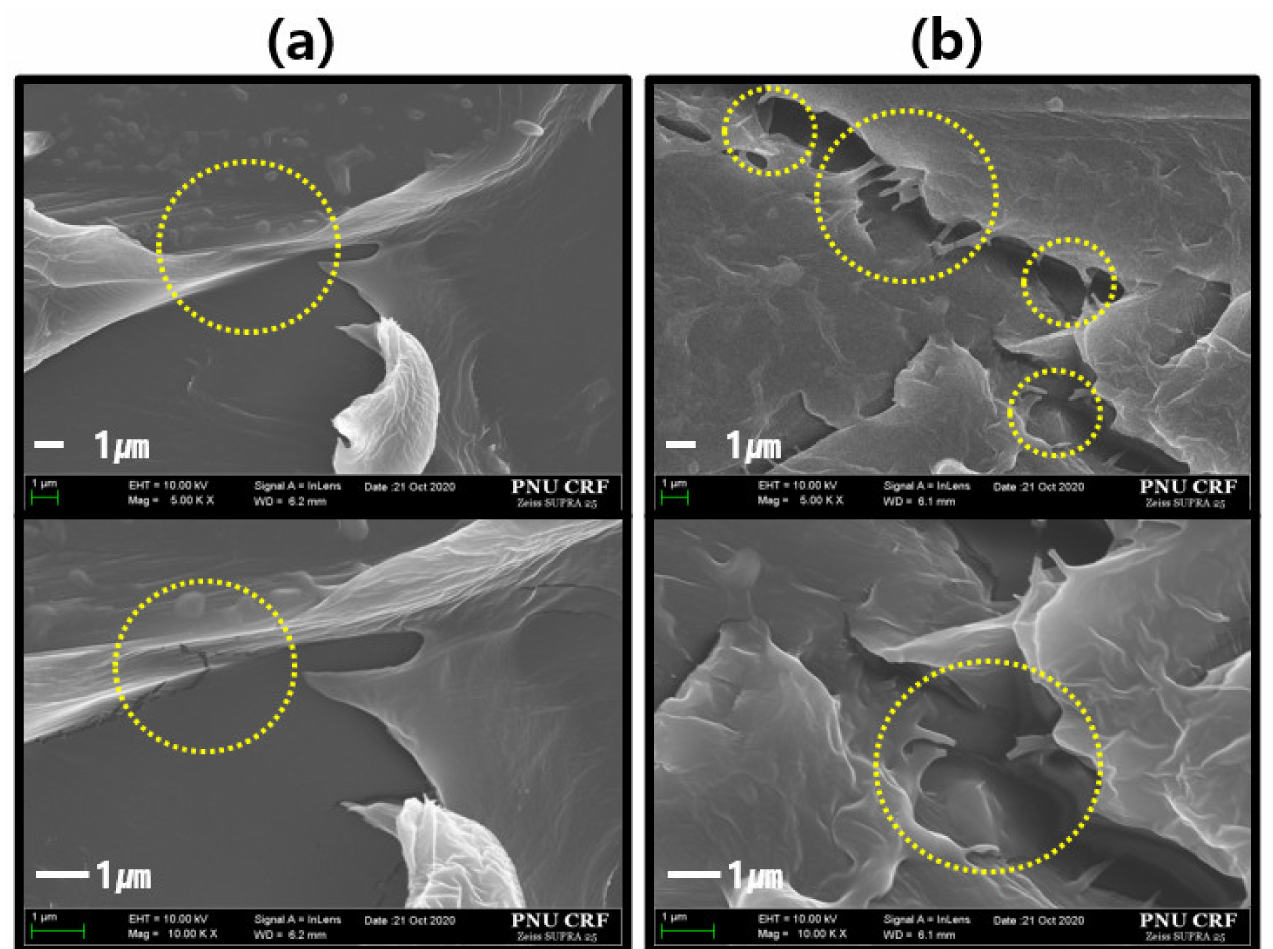
Figure 4. FE-SEM images of binder interfaces after detachment to adherend: ( a ) including 15 wt% TMSPMA, ( b ) not including 15 wt%